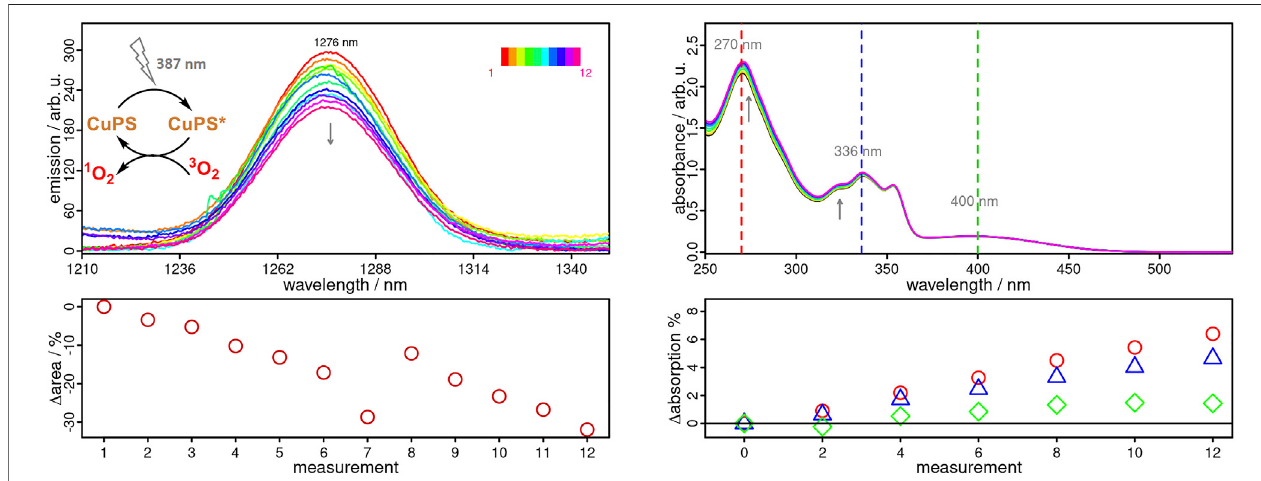
FIGURE 5 | Left Top: Near-infrared emission spectra of CuNIphen in aerated deuterated dichloromethane solution (CD 2 Cl 2 ) after excitation at 387 nm, showing the characteristic 1 O 2 emission at 1276 nm. The covered cuvette was shaken vigorously three times between each measurement. Left Bottom: Relative integral differences of the recorded 1 O 2 emission. Right Top: UV/vis absorption spectra of the same sample after every second emission measurement. Right Bottom: Relative differences in the absorbance of CuNIphen monitored at 270 (red), 336 (blue) and 400 nm (green),